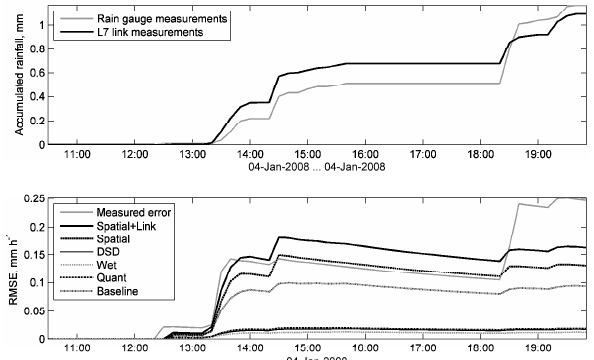
Fig. 8. Time series of accumulated gauge rainfall vs. microwave rainfall (upper plot) and measured vs. predicted RMSE (Eq. 50) of accumulated microwave rainfall estimates (lower plot). Contribution of various error sources into the total predicted error is shown in the lower plot, for L7 link and Switch Ramle gauge in 3 January 2008 rainstorm. Link length is 0.81 km, frequency is 23.27 GHz, ∆ t =10 minutes. Note the different scales of the upper and lower plots.